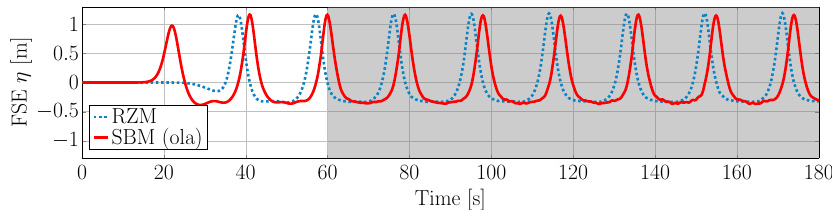
Figure 17. Plot of the free surface elevation (FSE) time traces at the centre of the CNWT for the RZM and SBM (ola). The interrogation window used for the zero up-crossing is shaded. For brevity, results are only shown for the OFWP.